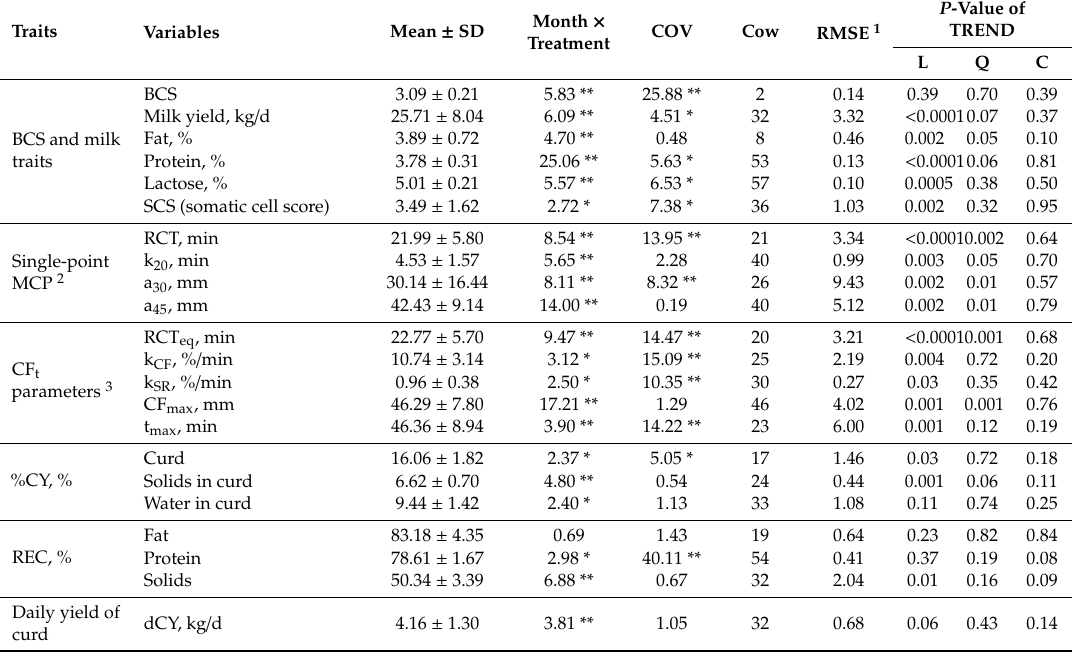
Table 1. Descriptive statistics (mean ± standard deviation) and results from the mixed model for body condition score (BCS), milk traits, milk coagulation properties (MCP), curd-firming modeling parameters (CF t ), percentage cheese yield (%CY), milk nutrients recovery in curd (REC), and daily yield of curd (dCY CURD ) of cows kept on the permanent farm or moved to temporary summer pasture (Treatment) during the June to October interval (Month): F-values and significance (* p < 0.05; ** p < 0.01) for the combined Treatment × Month fixed e ff ect, and for the covariate on the initial value of the trait (COV); percentage of variance explained by the random e ff ect of cow on total variance (Cow); P -value of the linear (L), quadratic (Q) and cubic (C) trends of the trait from June to October within permanent farm (TREND).